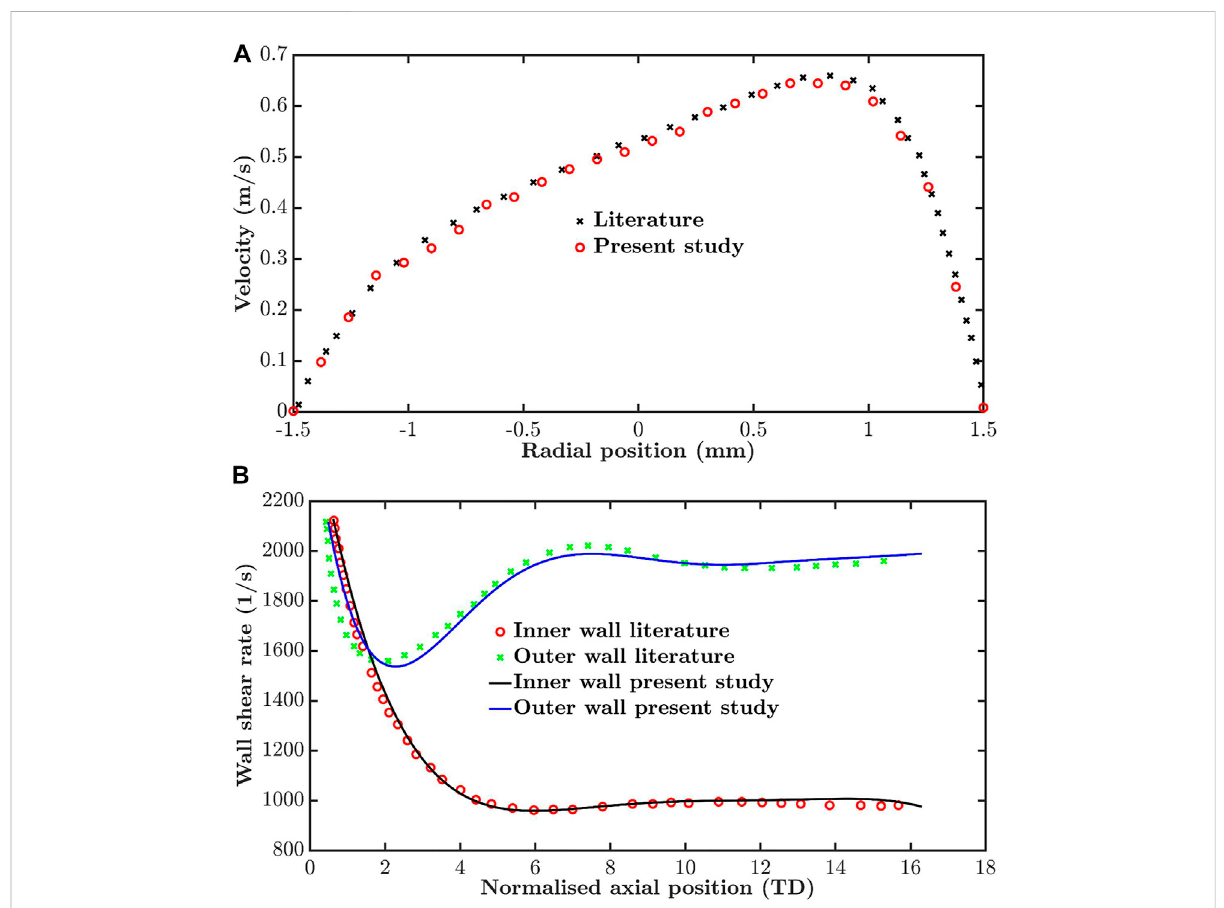
FIGURE 2 Validation by comparison of simulations for a tube of time-varying curvature with previously published values for the same dynamic geometry. (A) Velocity pro fi les thirteen tube diameters from the inlet and (B) wall shear rate along the inner and outer wall, both at t = 0.25 s in a period of 1